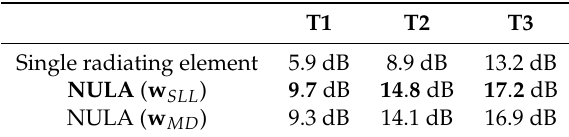
Table 12. Signal-to-Interference Ratios (SIR) study for the selected targets.